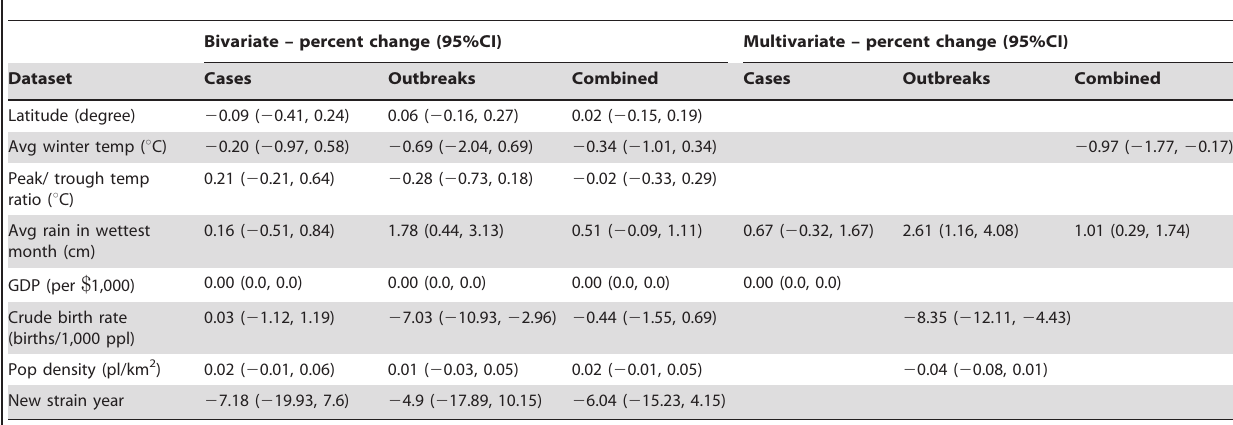
Table 1. Linear regression model results of associations between potential weather, socio-demographic, and viral predictors with norovirus season